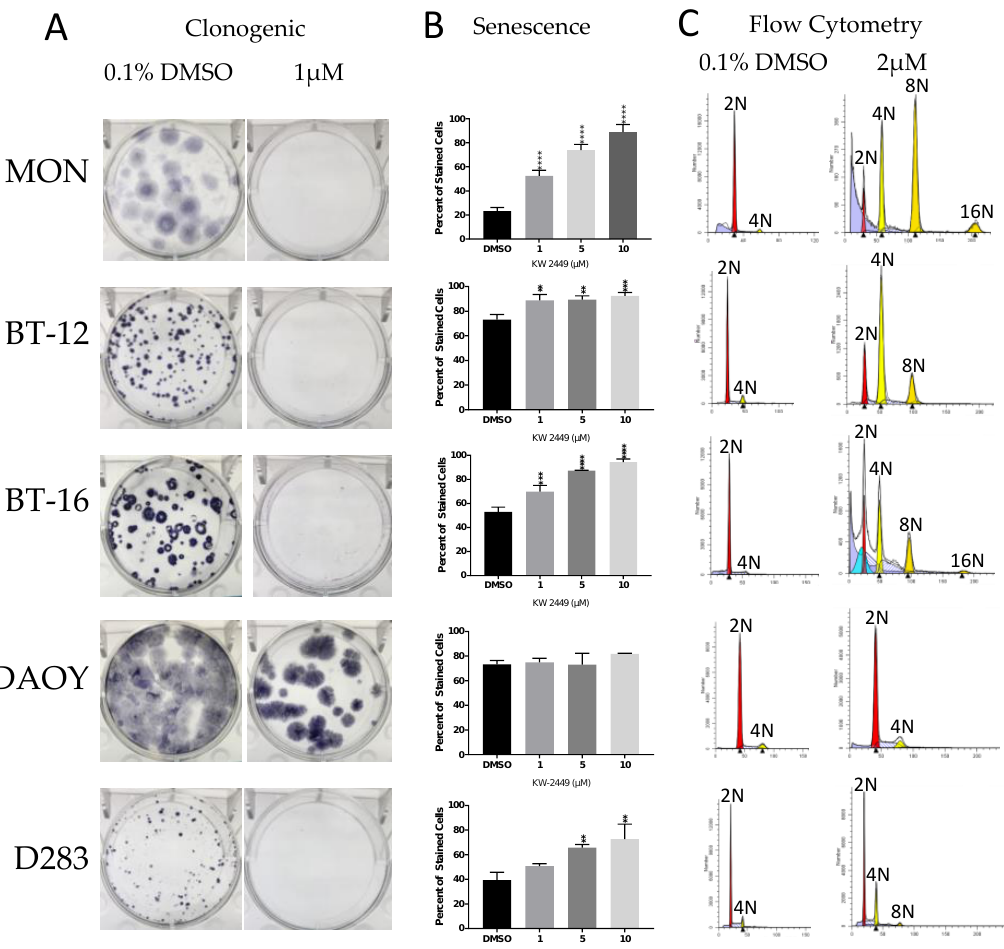
Figure 6. Phenotypic evaluation by KW-2449 in multiple cells lines. ( A ) Clonogenic - colony formation assay of RT and MB cells treated with 1 µ M KW-2449 reveals complete inhibition of colony formation in all cell lines except the MB cell line DAOY. ( B ) Beta-galactosidase assay shows a dose-dependent induction of cell senescence when treated with increasing doses of KW-2449 in all cell lines (** p < 0.01, *** p < 0.001 and **** p < 0.0001, one-way ANOVA). ( C ) Cell cycle analysis reveals the induction of polyploidy with 2 µ M KW-2449 in all cell lines except DAOY.